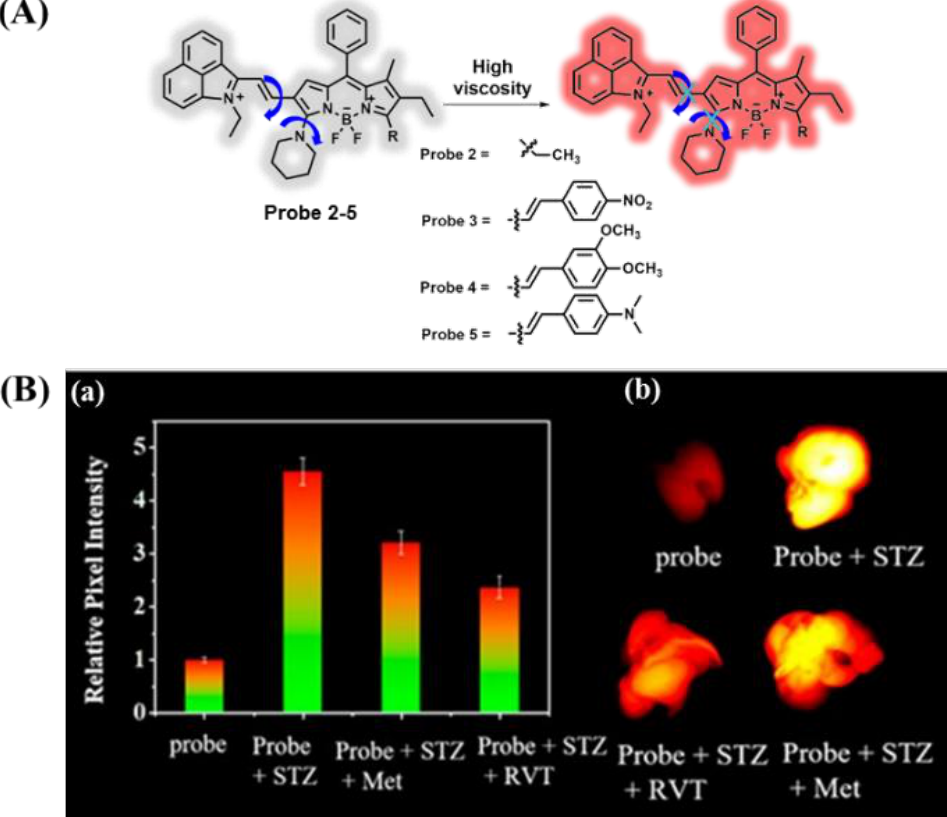
Figure 3. ( A ) Imaging mechanism of probes 2 – 5 ; ( Ba ) relative fluorescence intensity in mice livers treated with various drugs and probe 3 ; ( Bb ) ex vivo imaging of liver viscosity after drug treatment. Adapted from Reference [59]. Copyright 2020, American Chemical